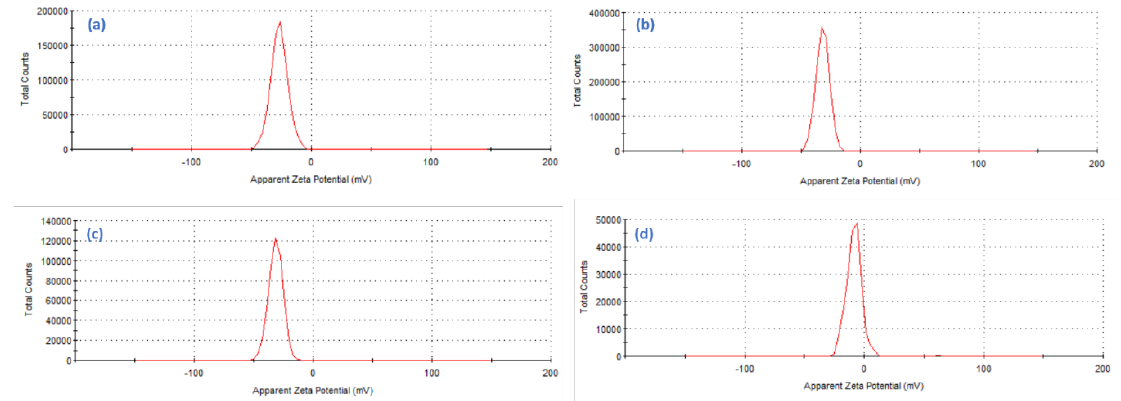
Figure 5. Zeta potential surface charge of ( a ) AgNPs, ( b ) TiO 2 NPs, ( c ) TiO 2 /AgNCs and ( d ) ZnO/TiO 2 /AgNCs.